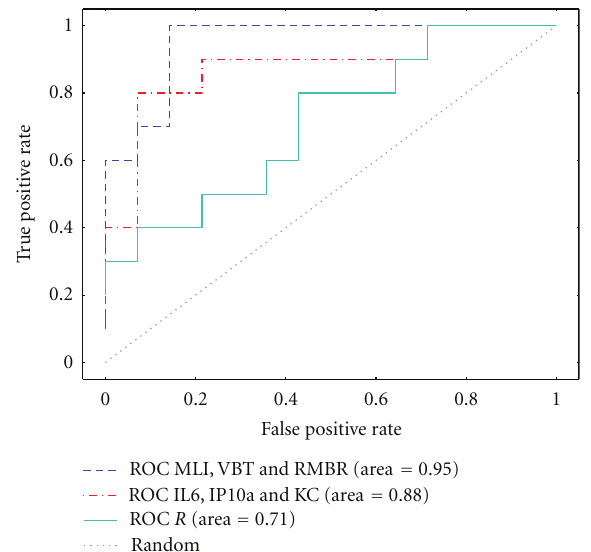
Figure 10: ROC curves of the classifiers tested on the best combination of features. The first set MLI, VBT, and RMBR were derived from micro-CT images. The second set corresponds to the RNA cytokine expression levels of IL6, IP10, and KC. The third set corresponds to the pulmonary functional parameter R . The features derived from micro-CT images show the best performance, because higher true positive rates can be obtained for the same false positive rate at most